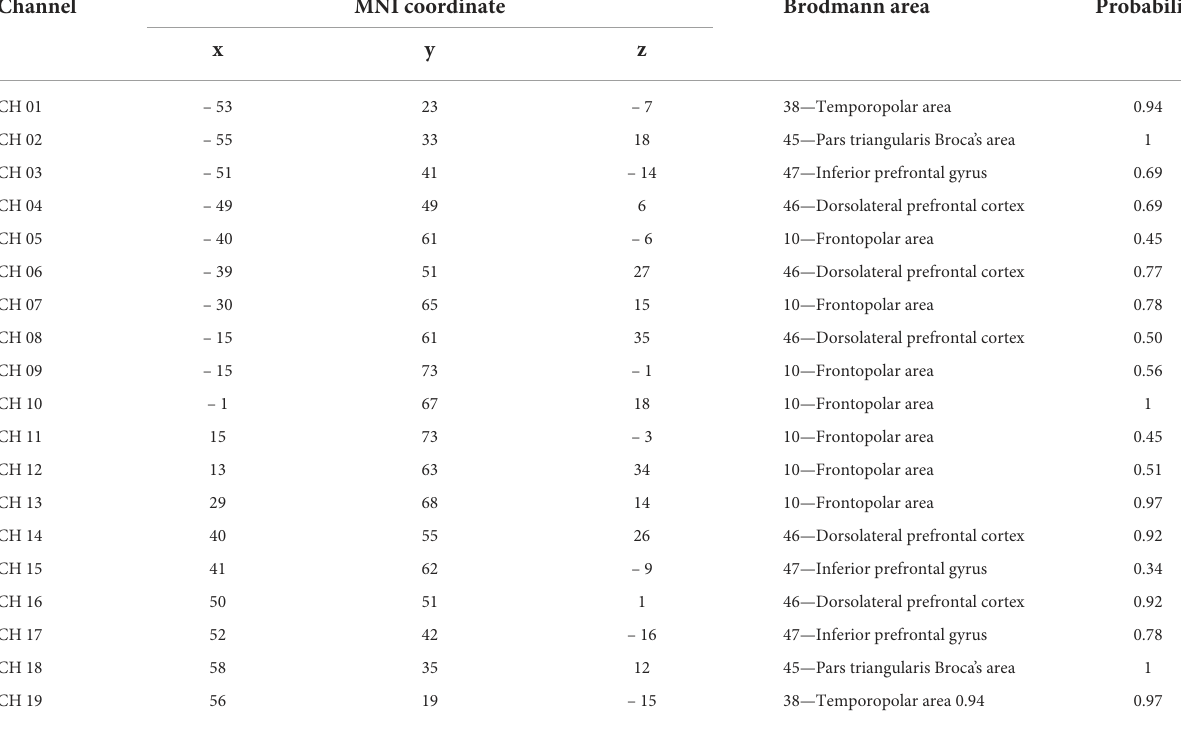
TABLE 1 The standard MNI coordinates and associated brain areas of the channels. Channel